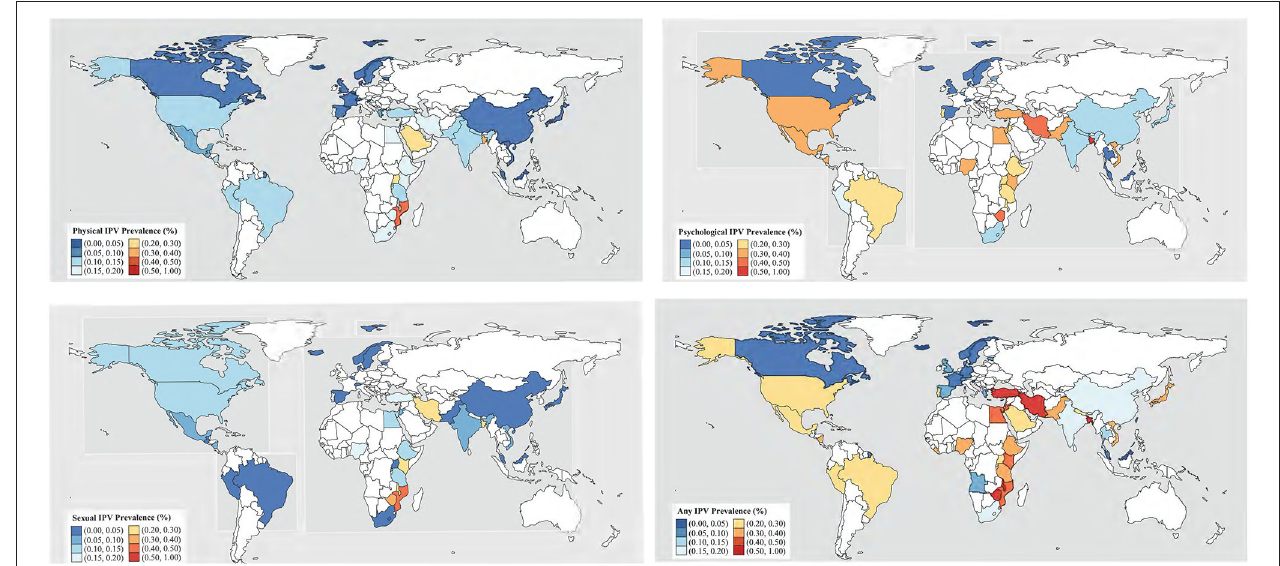
FIGURE 2 | World-wide distribution of intimate partner violence (IPV)